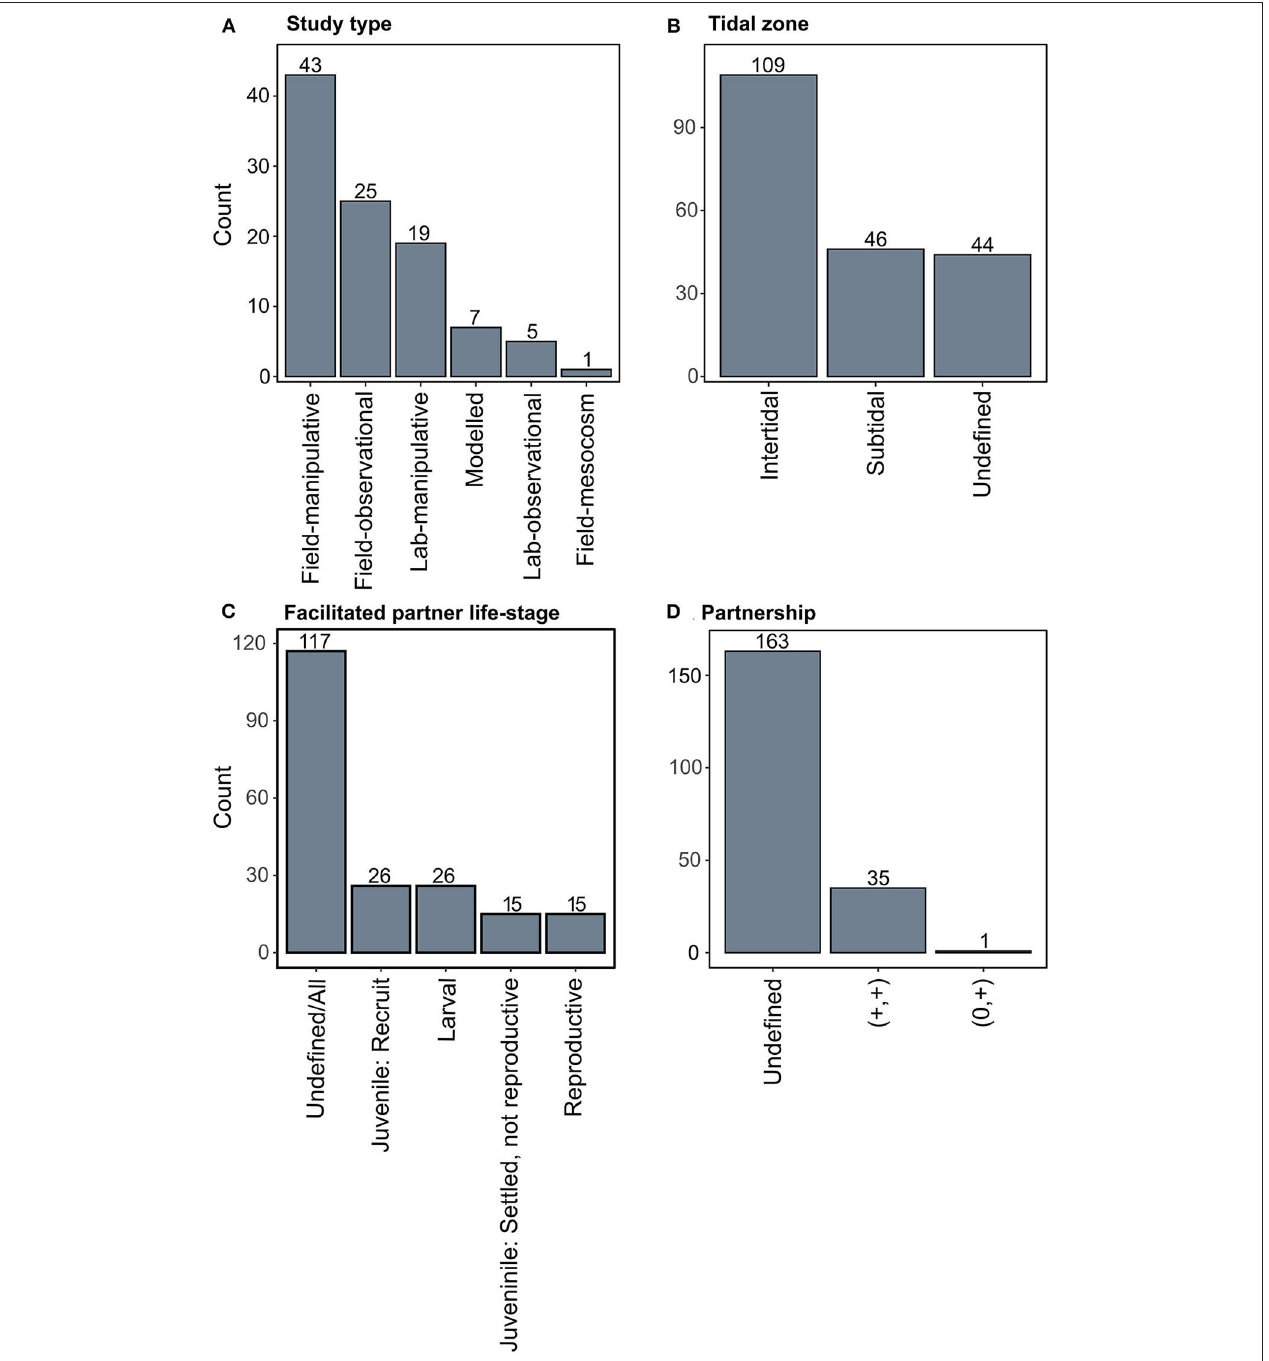
FIGURE 4 | Summary of key parameters for positive interactions from oyster beds and reefs. (A) Studies that identified positive interactions summarized by study type, (B) the tidal zone where the positive species interaction occurred, (C) the life-stage of the facilitated partner, and (D) the type of partnership for each species